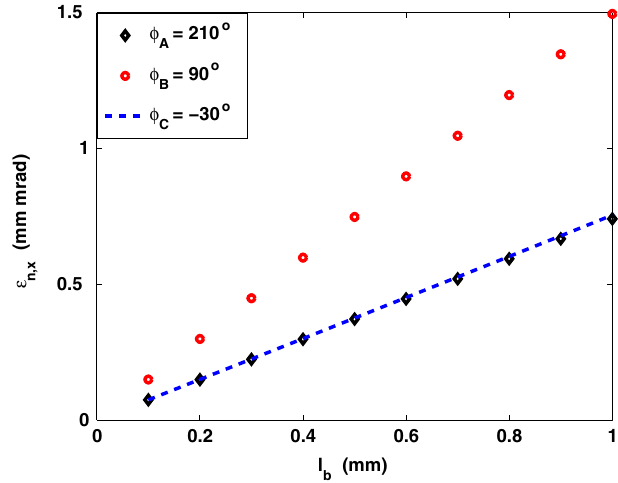
FIG. 13. Normalized rms projected emittance ( (cid:8) n;x ) for differ- ent bunch length ( l b ) corresponding to rf phases (cid:4) A;B;C